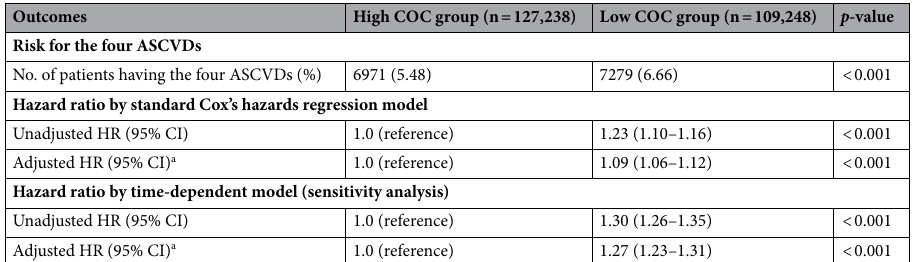
Outcomes High COC group (n = 127,238) Low COC group (n = 109,248) p -value Risk for the four ASCVDs No. of patients having the four ASCVDs